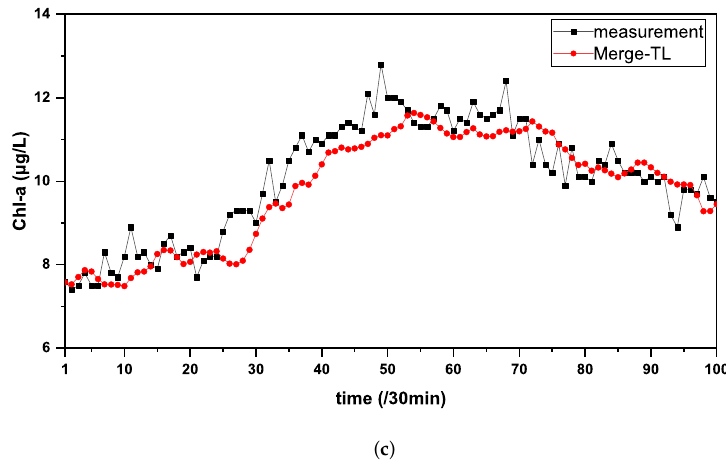
Figure 5. Visualization of 100 data points for each model prediction result, where the time period of the data points is from 23:30 on 27 September to 1:00 on 30 September. ( a ) Results of the T- CNN prediction model. ( b ) Results of the T-BiLSTM prediction model. ( c ) Results of the Merge-TL prediction model.